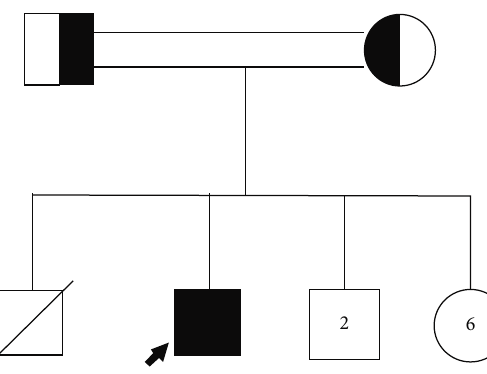
Figure 1: Pedigree chart of the